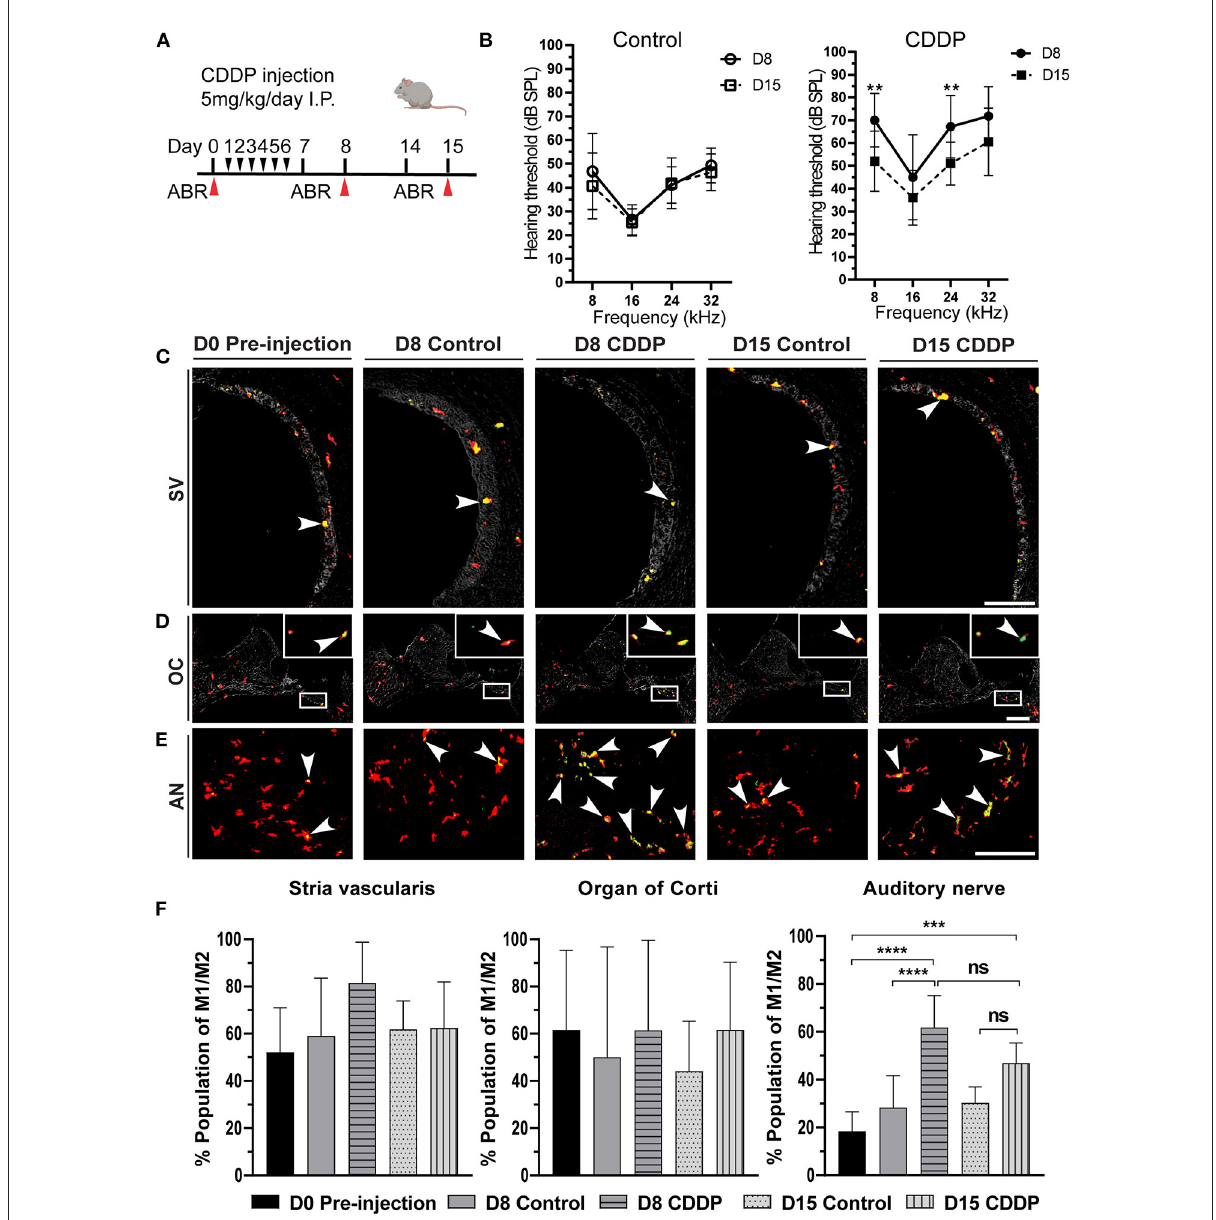
FIGURE3 Cisplatin induced temporary hearing threshold shift and macrophage activation. (A) The protocol for cisplatin injection (red arrows indicates the time of euthanasia). (B) Auditory brain stem response (ABR) thresholds [dB sound pressure level] at 8, 16, 24, and 32kHz in the control and cisplatin groups of 5-week-old mice just after cisplatin injection (day 8) and after 2 weeks (day 15). There was a temporary threshold shift at day 8 ( n = 14), which significantly improved at day 15 ( n = 10) at 8kHz ( P = 0.0056), and 24kHz ( P = 0.0166) but was insignificant at 16kHz ( P = 0.4854) or 32kHz ( P = 0.1908). There was no significant difference between the hearing thresholds of the control groups ( n = 14 for each group). Statistical analysis was done by two-way ANOVA with the Bonferroni post hoc test. The error bars represent standard deviation from the mean. (C) Activated macrophages in the stria vascularis. (D) Activated macrophages in the organ of Corti. The box shows the magnified region of the macrophages in the organ of Corti. (E) Activated macrophages in the auditory nerve. The arrowhead represents the activated macrophages (yellowish green color). There was a marked increase in the activated macrophages of the auditory nerve area on day 8 post-cisplatin injection. However, this activation was temporary, and the number of activated macrophages was reduced on day 15. AN: auditory nerve, SV: stria vascularis, OC: organ of Corti. Scale bar: stria vascularis, 90 µ m; Organ of Corti, 200 µ m; auditory nerve, 40 µ m. (F) Statistical analysis of the ratio of activated macrophages in different sites of the cochlea. In the Stria vascularis and organ of Corti, there was no significant difference in the amount of activated macrophages between the different groups. In the auditory nerve, there was significant increase in the number of activated macrophages on day 8 ( n = 10). This activation was insignificantly reduced on day 15 ( n = 8), *** P < 0.001, **** P < 0.0001, ns: not significant, by one-way ANOVA with Tukey’s multiple comparisons test. The error bars represent standard deviation from the